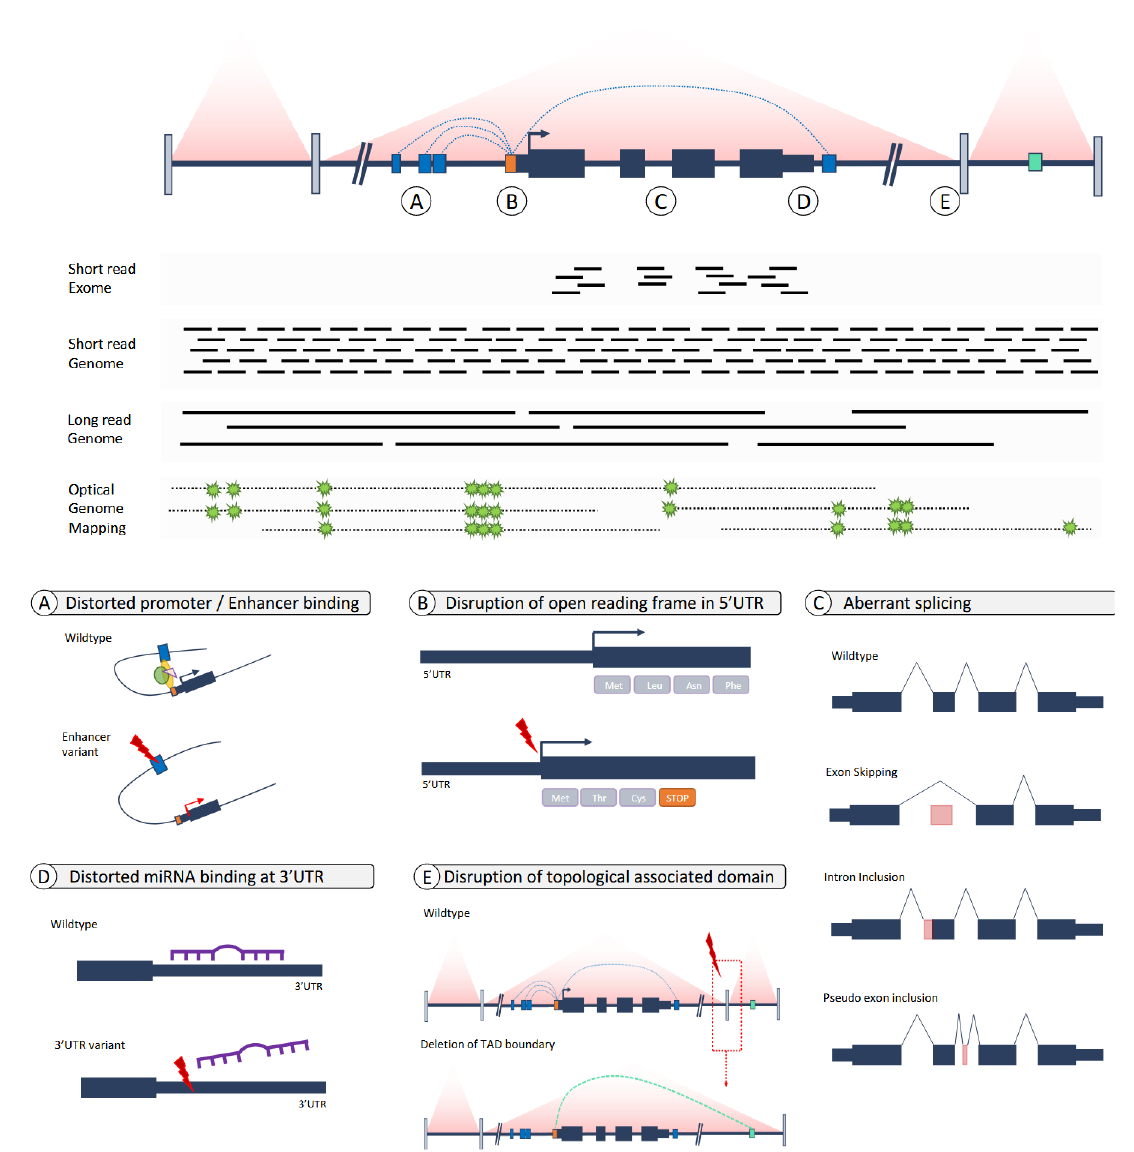
Figure 7. Overview of technological developments and the role of non-coding DNA variants in ID. Top panel shows schematic genomic structure with a gene in a topological-associated domain. Below this structure, different technologies are depicted which are commonly used to identify the genetic cause of NDD, including exome sequencing, short- and long-read genome sequencing and optical genome mapping (in green: labels detected in optical genome mapping technology). In the structure, the letters represent mechanisms, detailed out in the bottom panel, on how variants in non-coding DNA sequence can lead to disease. ( A ) Rare variants in an enhancer may lead to the distortion of binding of the enhancer to the promoter, effectively resulting in failure of transcription. ( B ) Rare variants in the 5′ UTR may lead to the introduction of a novel translation initiation site, resulting in a shift of reading frame and effectively leading to haploinsufficiency. ( C ) Rare variants in the intronic sequence may lead — by different mechanisms — lead erroneous splicing, creating an out of frame transcript and resulting in haploinsufficiency. ( D ) Within the 3 (cid:48) UTR, multiple miRNA binding sites are present to regulate transcription. Rare variants in these sites may prevent miRNA binding and, thus, correct regulation of transcription. ( E ) Transcriptional regulation by enhancers and silencers is organized within topological-associated domains (TADs). Deletion of such a boundary may place genes under the control of ectopic enhancers and/or silencers of neighboring TADs, leading to dysregulation of gene